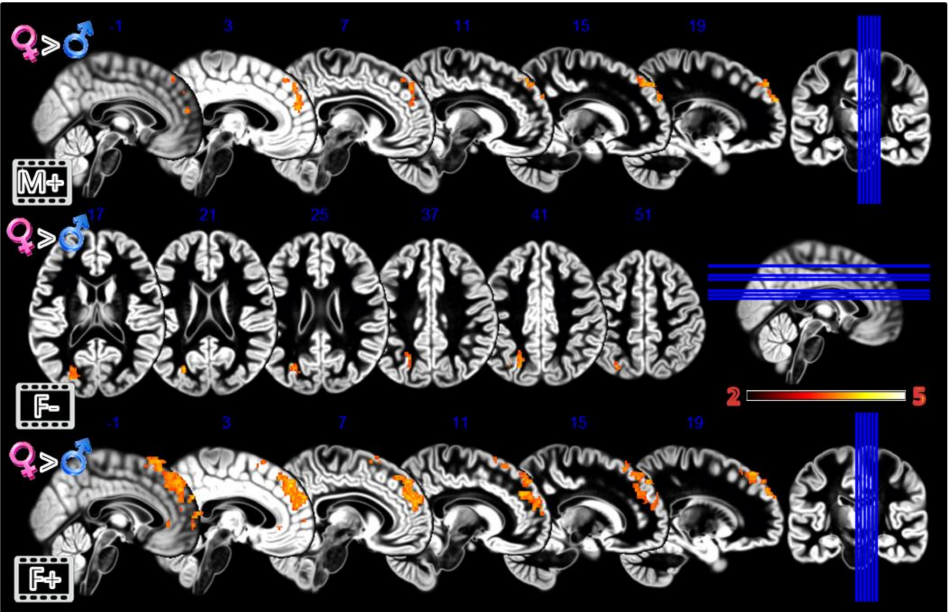
Figure 5. Group differences for the Dynamic Morphing experiment. All the rows Females greater than Males for masculinization ( first row ), defeminization ( second row ) and feminization ( third row ) morphings. In red significant clusters ( p corr < 0.05) on a gray matter ICBM brain template, neurological convention, color scale in the bar maps for Z scores. In blue MNI coordinates in mm, and lines to show the slice positions on the orthogonal projections (right side of the